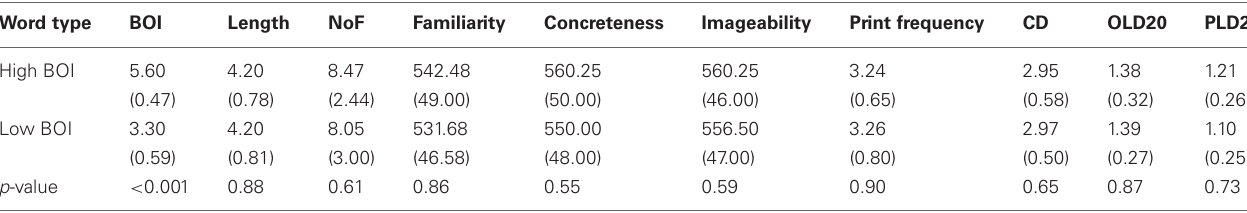
Table 1 | Mean characteristics (Standard Deviations in parentheses) for word